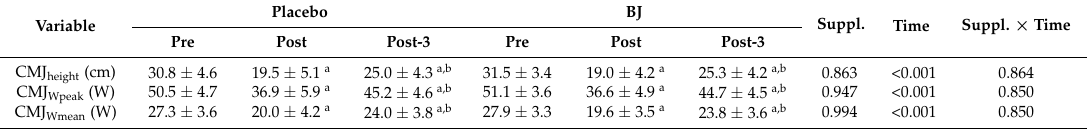
Table 2. Effects of placebo or BJ intake in a neuromuscular fatigue (CMJ) after a 30-s all-out Wingate test.